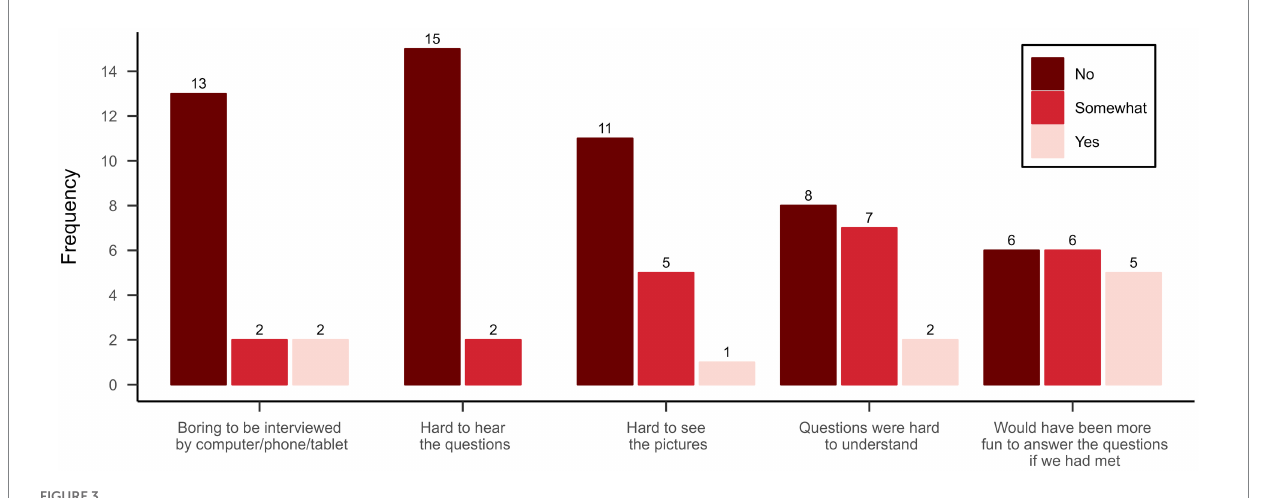
FIGURE 3 Participants attitudes toward the interview and the digital